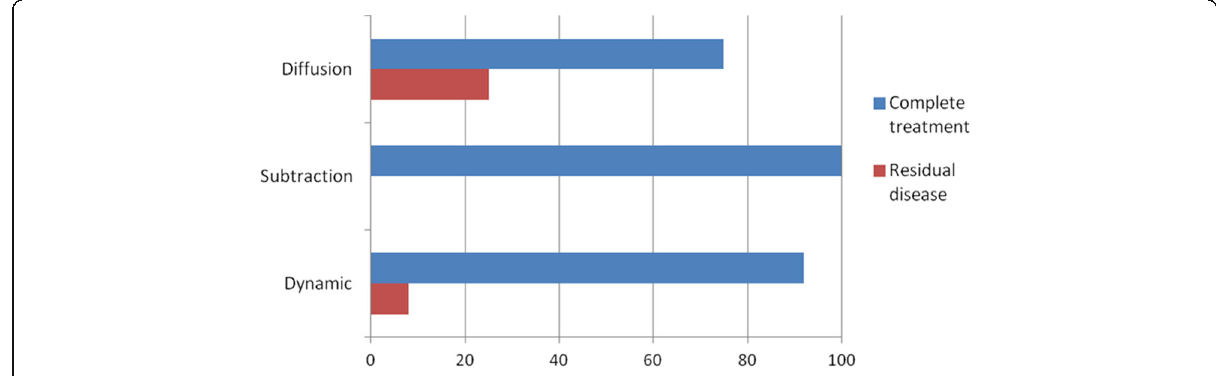
Fig. 3 Horizontal graph showing the correlation of reader 1 findings to standard of reference (expressed as